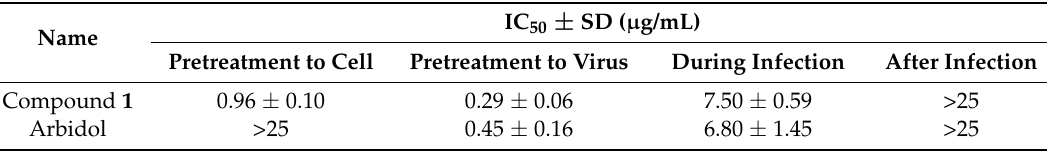
Table 2. The anti-influenza A viral activity of 1 in various administration time *.